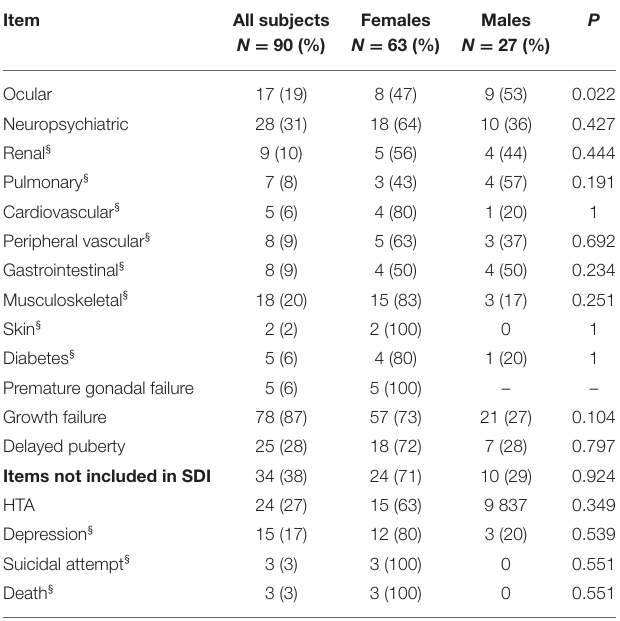
TABLE 3 | Main categories of damage (SDI) overall and by